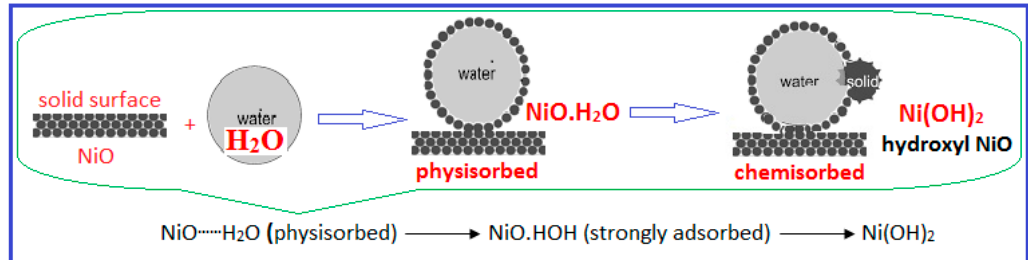
Scheme 1. Pictorial representation of the reaction mechanism.